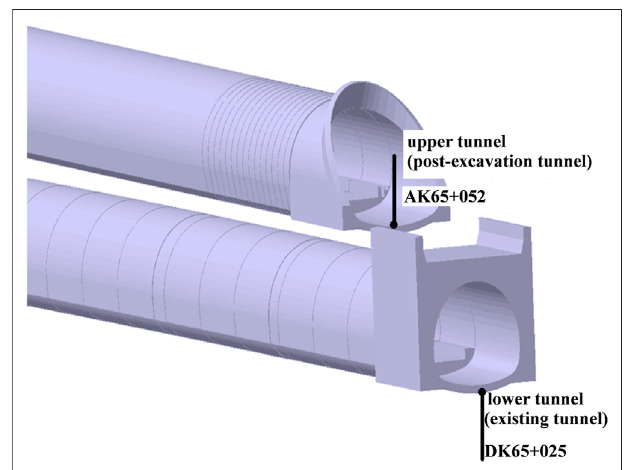
FIGURE 1 | Schematic diagram of the spatial location of the Bajiaogou overlapping